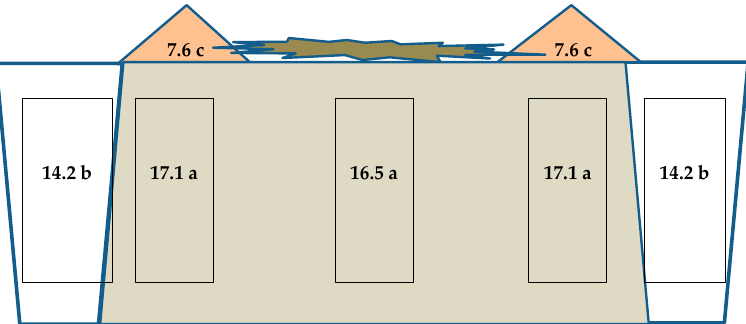
Figure 7. Spatial differentiation of soil moisture (% v/v ) immediately after sowing maize. The letters a, b, and c indicate significant difference at p < 0.05.